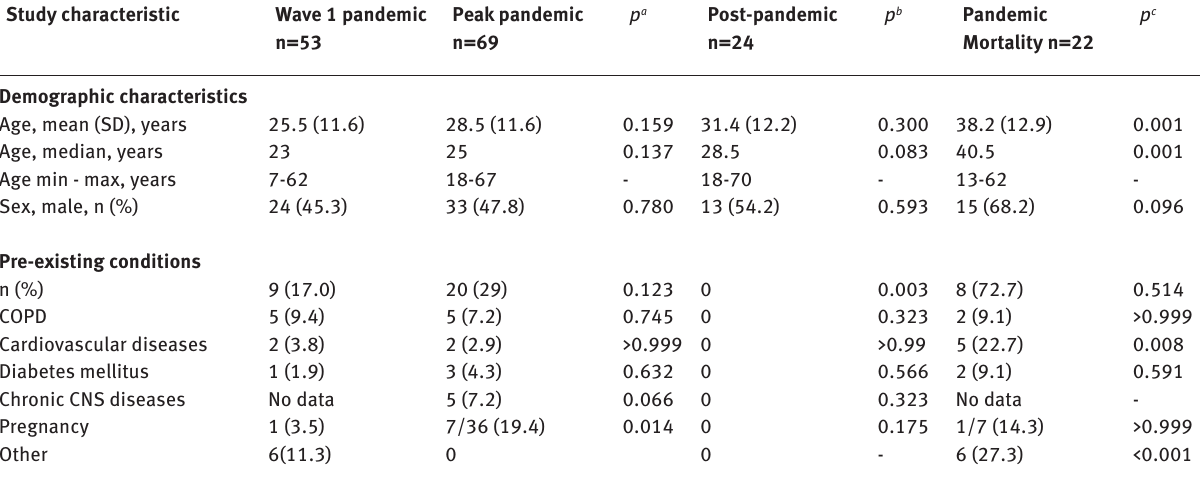
Table 1: Baseline demographic characteristics and pre-existing conditions of patients with influenza A(H1N1)pdm09 infection. Study